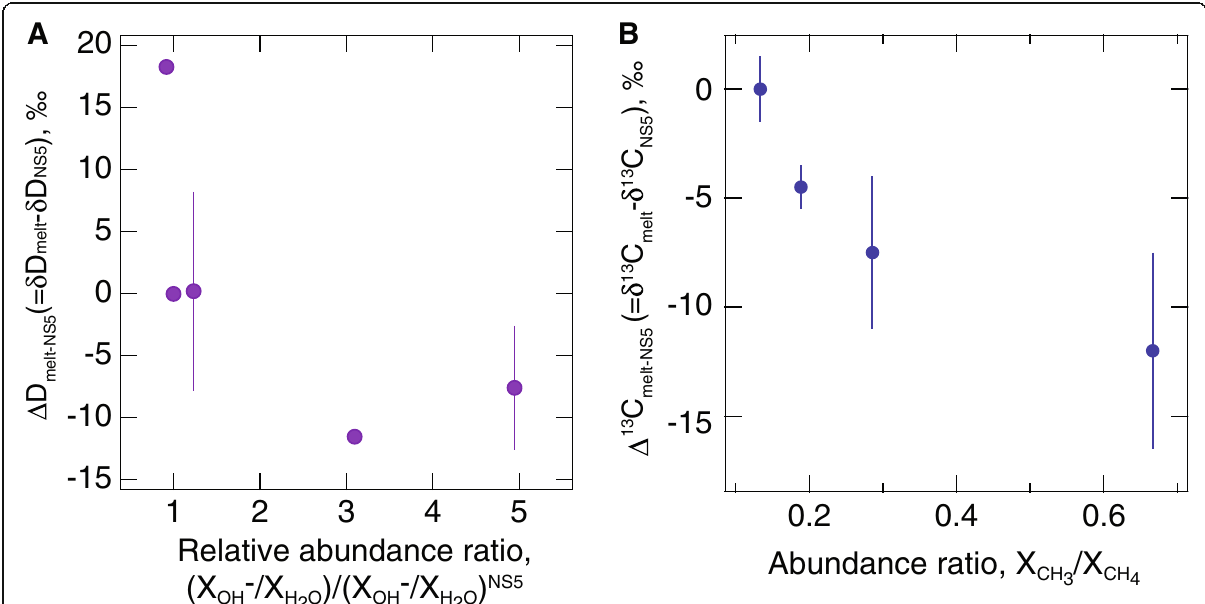
Fig. 4 Changes in hydrogen and carbon isotope ratios of melts in equilibrium with fluid in melts equilibrated at 1400 °C and 2 GPa with the hydrogen fugacity controlled at the IW-H 2 O buffer. a D/H change expressed as a function of speciation of dissolved water relative to that of composition NS5 (Na 2 O · 5SiO 2 ). (data from Mysen and Fogel 2010). b Changes in carbon isotope ratio in melts relative to composition NS5 (Na 2 O · 5SiO 2 ) as a function of speciation of reduced carbon species (data from Mysen et al.